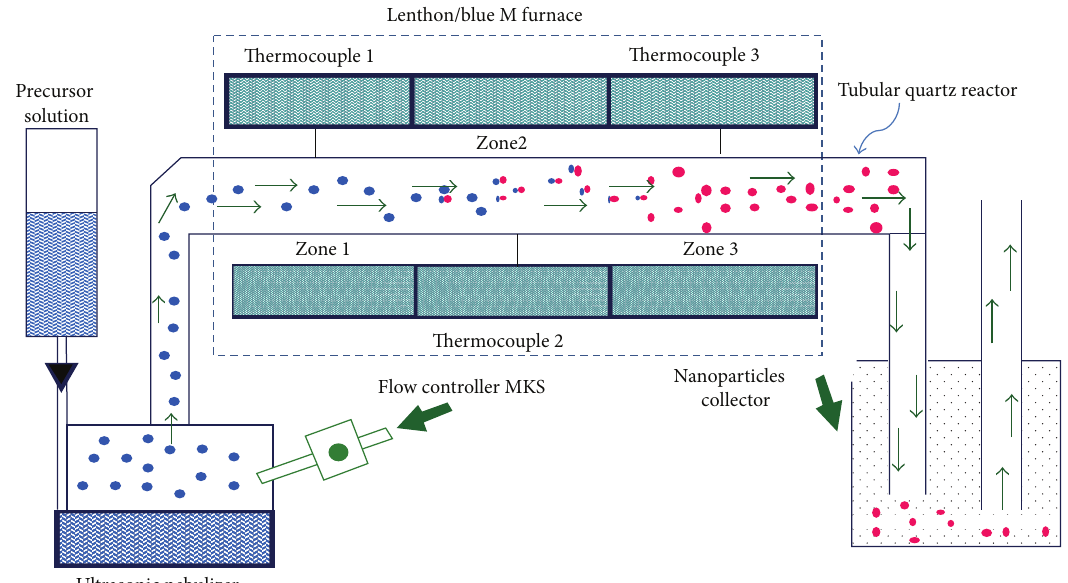
Figure 1: Schematic diagram of the USP system with horizontal